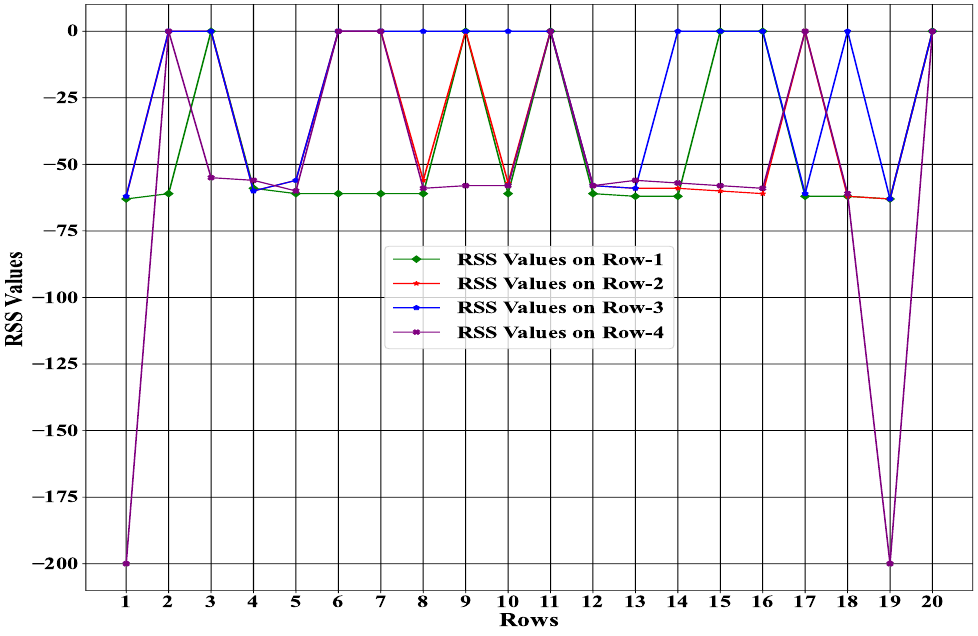
Figure 6. Example of some rows with 20 RSS